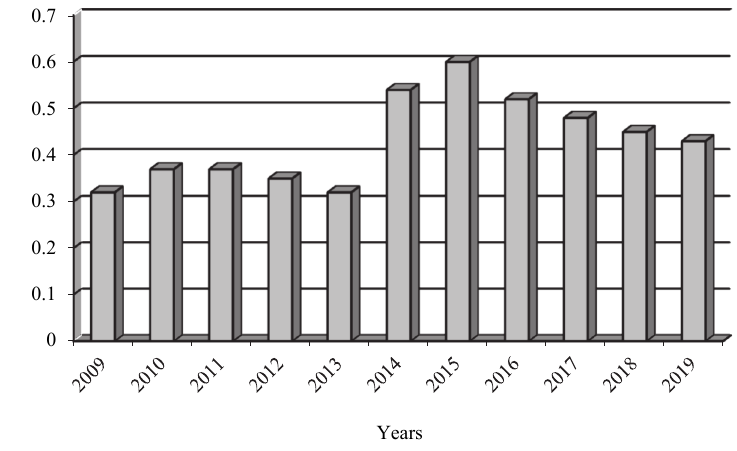
Fig. 1. Dynamics of change of the integrated indicator of the level of Ukraine’s economic security for the period 2008-2019 Source: own